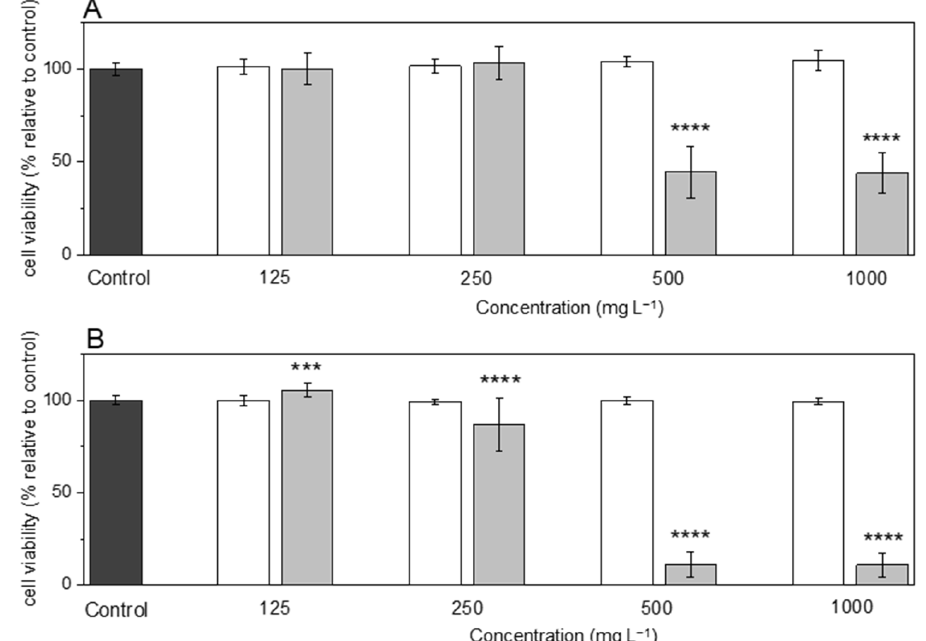
Figure 6. Cytotoxicity studies of A. macleodii Mo 169 EPS ( ) and the EPS/SeNPs bio-nanocomposite ( ) on CCD-10795k ( A ) and HaCaT ( B ) cell lines after 24 h incubation. Control experiments ( ) were performed by incubating the cells with only culture medium. Statistically significant differences comparing samples with the control were calculated according to the t -test (***, p ≤ 0.001, **** p ≤ 0.0001).